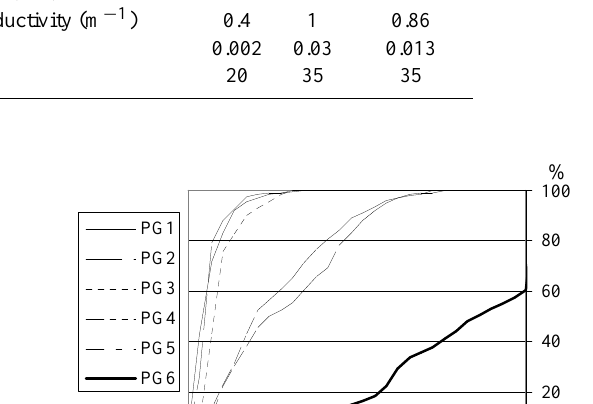
Table 2. Values of the parameters in the Monte Carlo analysis and in the sensitivity analysis. Values of the parameters Monte Carlo Sensitivity Analysis Analysis Min Max Reference Total porosity (%) 22 32 23 Figure 3. Variations of the water table depth: A) Temporal distribution of the water table Drainable porosity (%) 3 4.4 b , parameter of exponential depth function of drainable porosity (m − 1 ) 2 4.2 depth in the six wells, calculated on five water years (1998 to 2002); B) Reactivity of the K o, saturated hydraulic conductivity at soil surface (m/h) water table depth versus rainfall amount, calculated for all the rainfall events of five wet m , parameter of exponential depth function of conductivity (m − 1 ) seasons (January to March, from 1998 to 2002 ) (N=88).